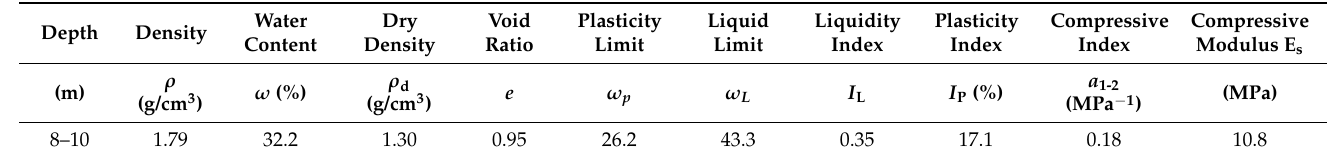
Table 1. Physical and mechanical average parameters of granite residual